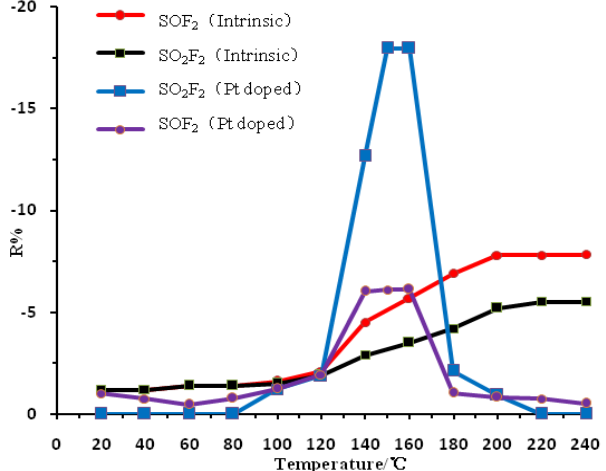
NTs sensors at different operating 2